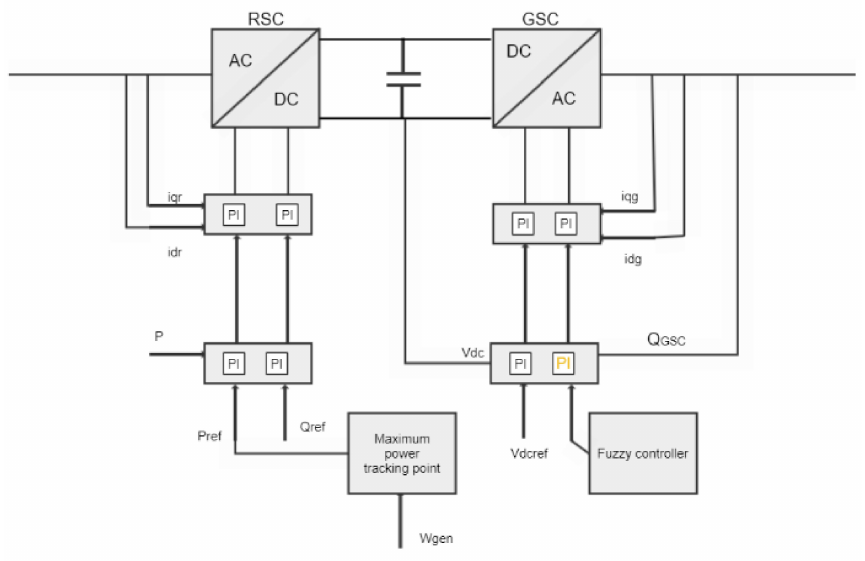
Figure 3. The structure of RSC and GSC